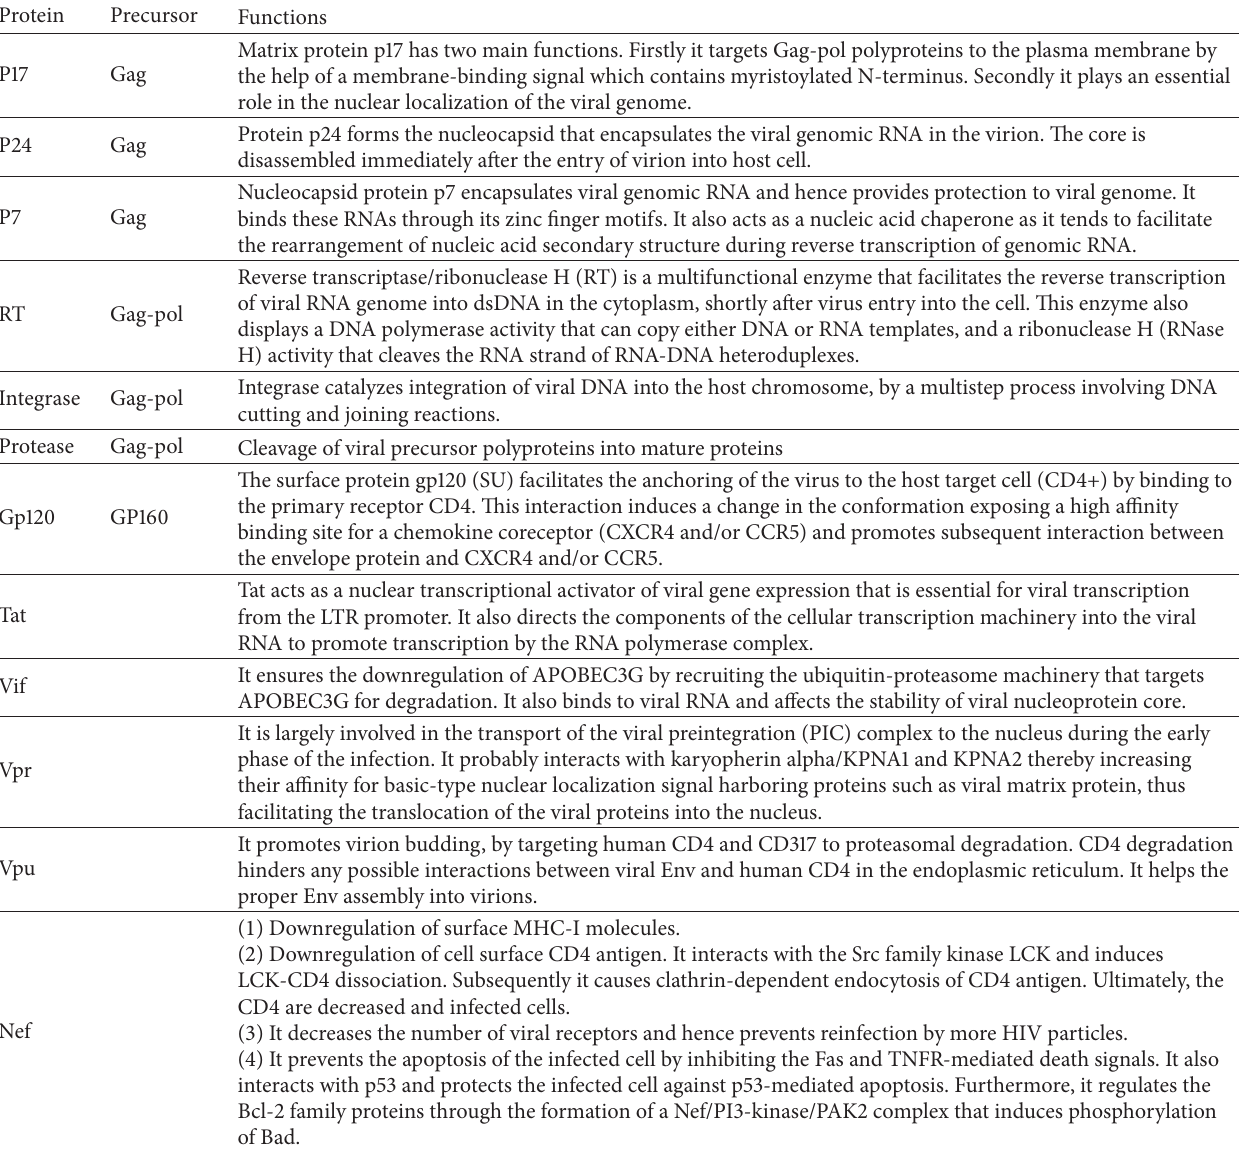
Table 1: Function of different HIV